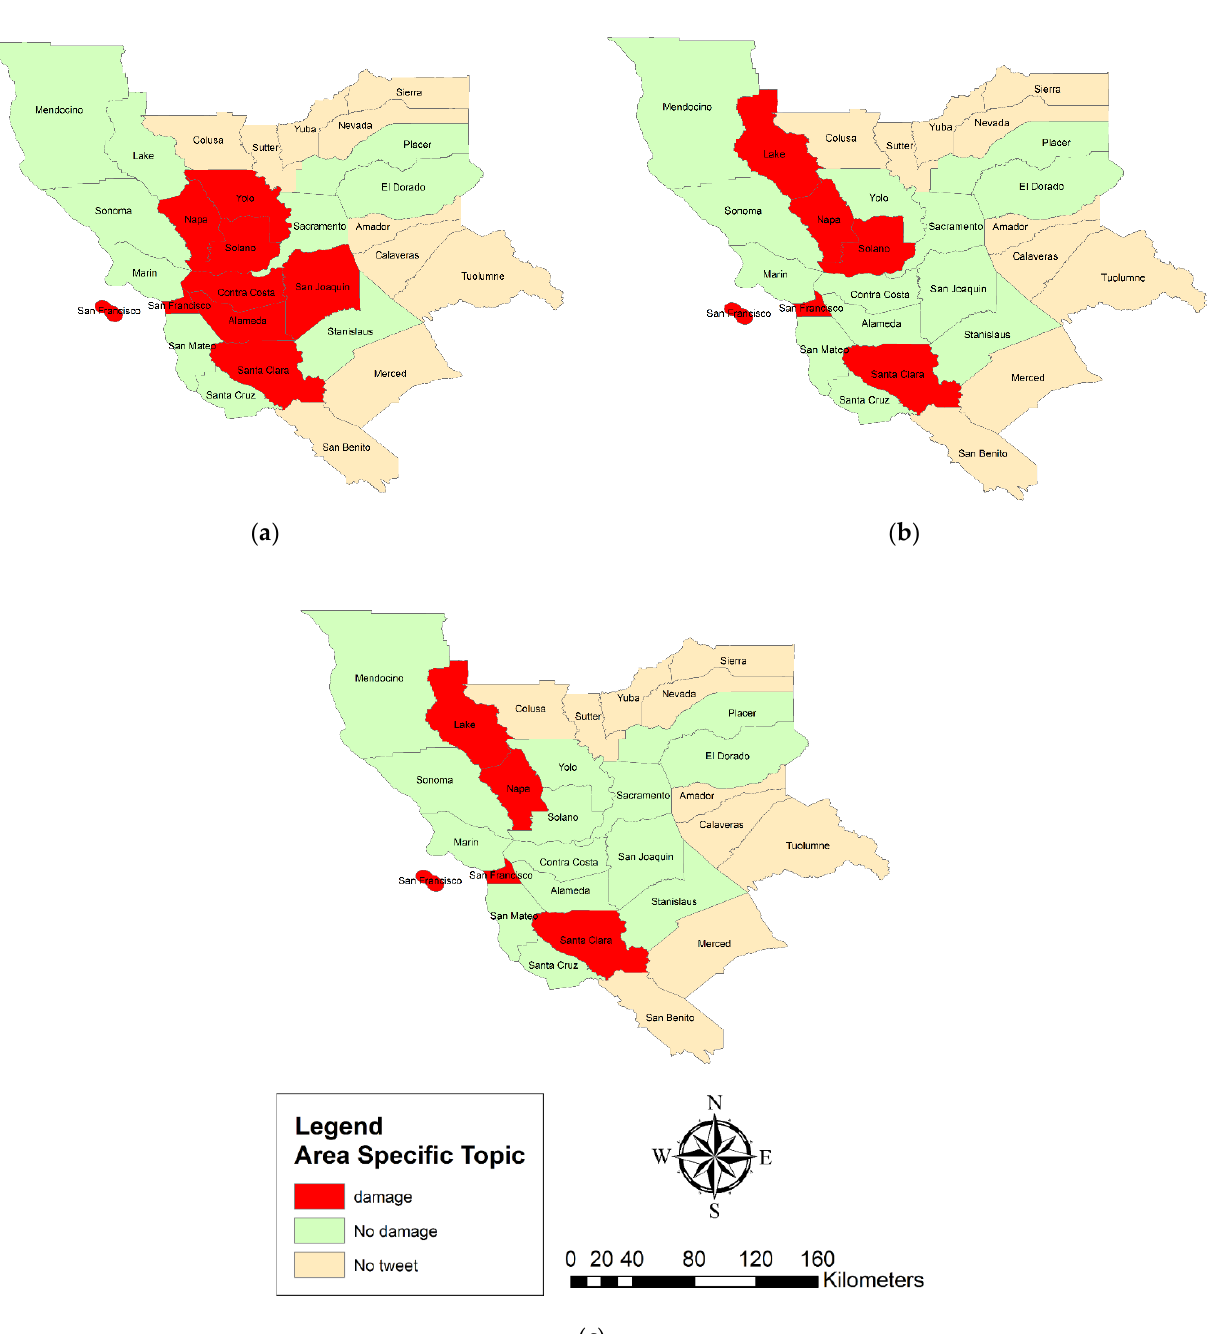
Figure 8. LQ analysis of the tweets ’ spatial topic concentration at the county scale, classified by Naive Bayes ( a ), SVM ( b ), and deep learning ( c ) in the two classes of damage and non-damage.